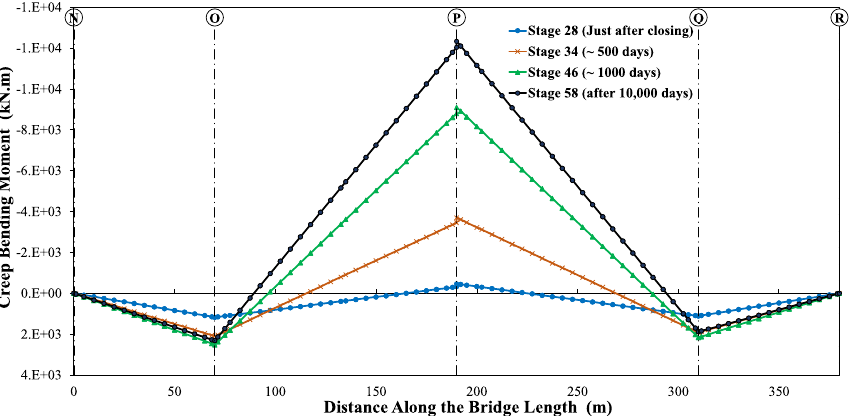
Fig. 9 Creep-induced bending moment due to all permanent loads along El-Warrak prestressed bridge deck at different ages starting from end of construction (i.e., after installing closure segments and applying all continuity